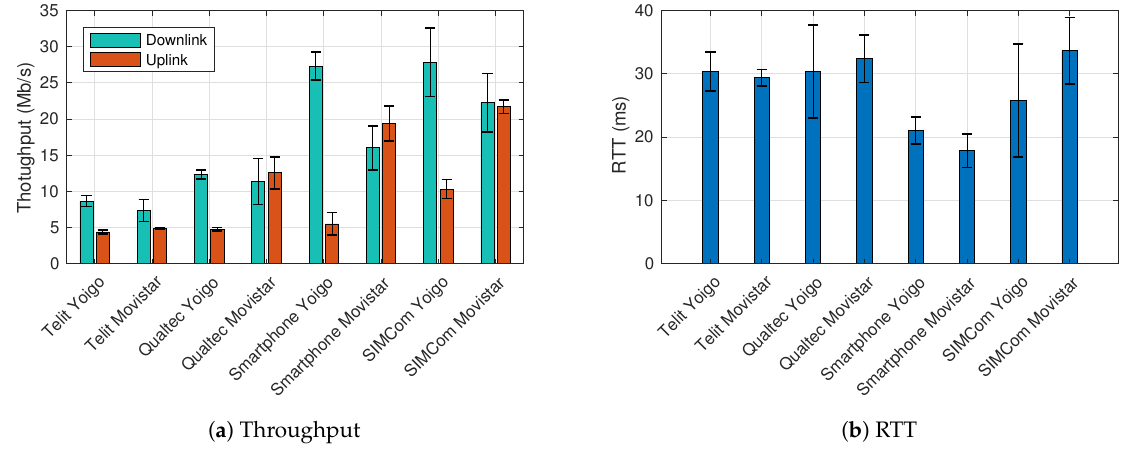
Figure 4. Performance analysis using Ookla speed